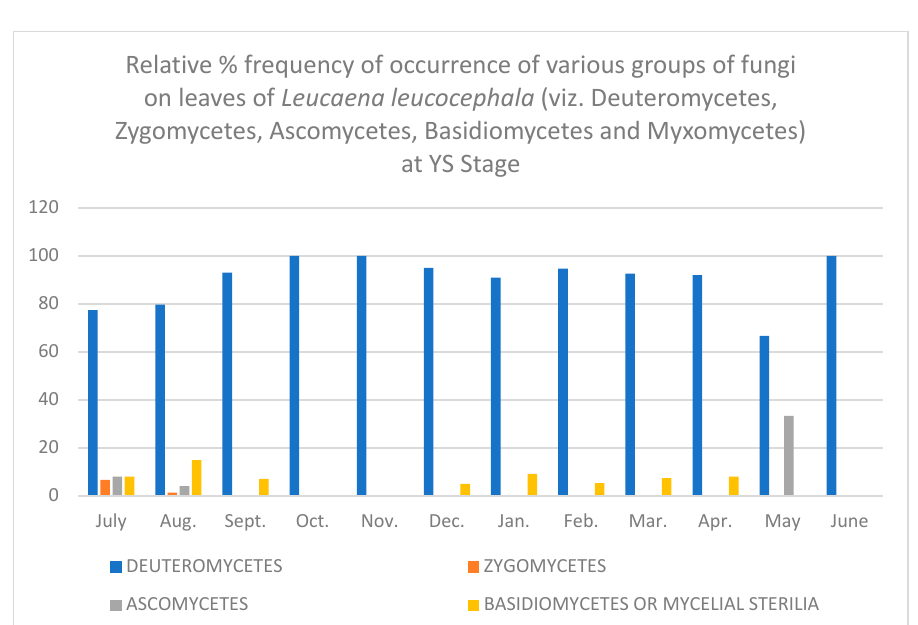
Figure 2. Relative % frequency of occurrence of various groups of fungi on leaves of Leucaena leucocephala (viz. Deuteromycetes, Zygomycetes, Ascomycetes, Basidiomycetes and Myxomycetes) at YS Stage. Table 3. Percentage frequency of occurrence of various fungi on leaves before they fall on ground (YD).